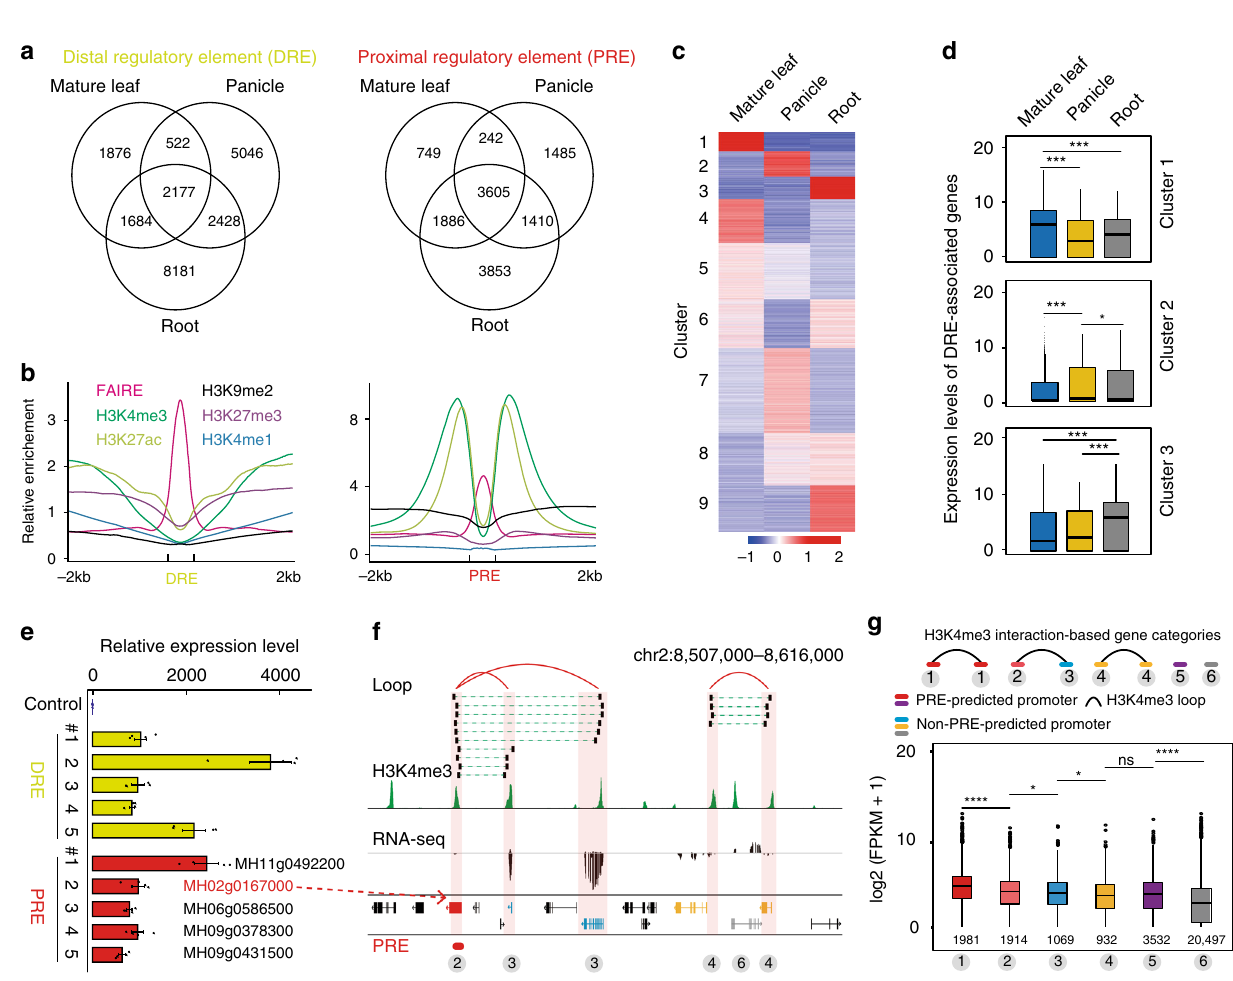
Fig. 5 Epigenetic characteristics of open chromatin region and enhancer-like promoter. a Venn diagram showing the overlap between distal regulatory element (DRE) and proximal regulatory element (PRE) in the mature leaf, panicle, and root of MH63. DREs and PREs were de fi ned in Supplementary Fig. 15. b Epigenetic features of DREs and PREs in mature leaf. Element regions were scaled to equal size. c Heatmap of tissue-speci fi c DREs showing dynamics between the indicated tissues. Tissue-speci fi c DREs were divided into nine clusters based on their signal intensities. d Boxplots of the expression levels of genes proximal to the tissue-speci fi c DRE in the clusters de fi ned in ( c ). n = 4113, 3067 and 3465 are the number of genes in clusters 1 − 3, respectively. *** p < 0.001 from Wilcoxon test. e Validation of DRE and PRE-predicted enhancers. Enhancer-like promoter refers to a promoter occupied by PRE. A transient reporter assay was used to examine the effects of these two types of regulatory elements on gene expression in rice protoplasts. One genic fragment (chr2:28,412,151-28,413,151) without epigenetic signal served as negative control. Each value represents the mean ± standard error of mean ( n = 4 biological replicates). f A representative example for enhancer-like promoter with chromatin loops. The representative enhancer-like promoter (MH02g0167000, red) was validated in ( h ). g Expression level of genes in different categories based on H3K4me3-associated chromatin interaction models and PRE-occupancy. The number of different types of genes were labeled. Boxplots in ( d ) and ( g ) include a median with quartiles and outliers above the top whisker. **** p < 0.0001 and * p < 0.1 from Wilcoxon test; ns means no signi fi cant. The numbers indicate the sample sizes used in the analysis. Source Data underlying Fig. 5c − e, g are provided as a Source Data fi